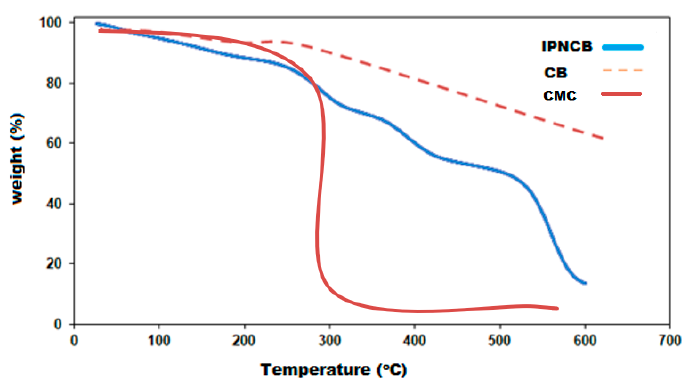
Figure 6. TGA of Carboxy Methyl Celleluse (CMC), Biochar (CB), and Interpenetrating Network Biohar composite (IPNCB). Biohar composite